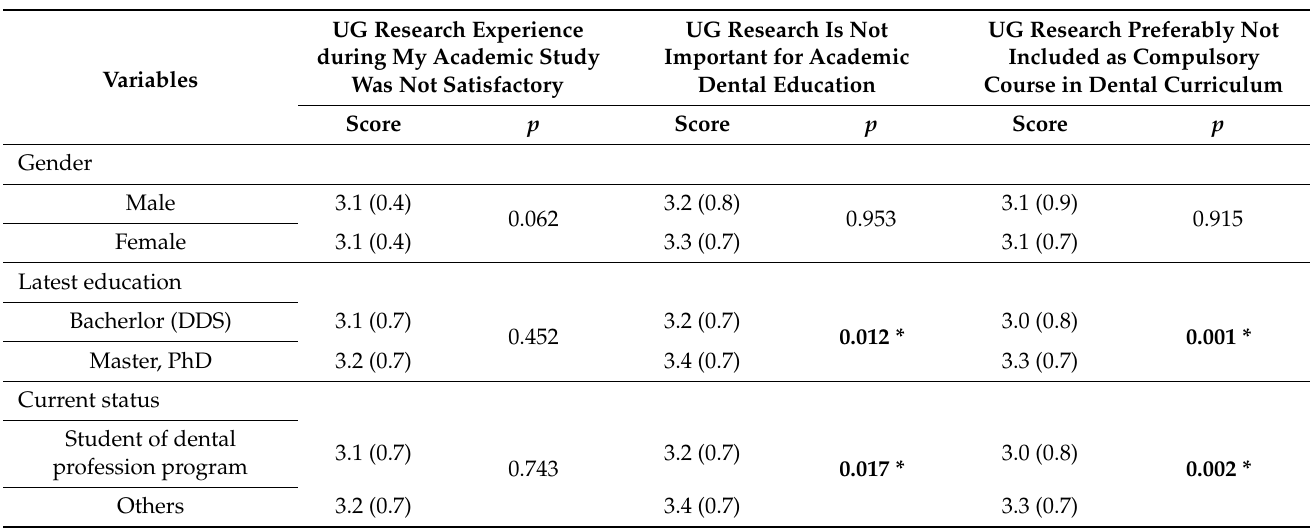
Table 4. Researchers Profile with Negative Undergraduate Research